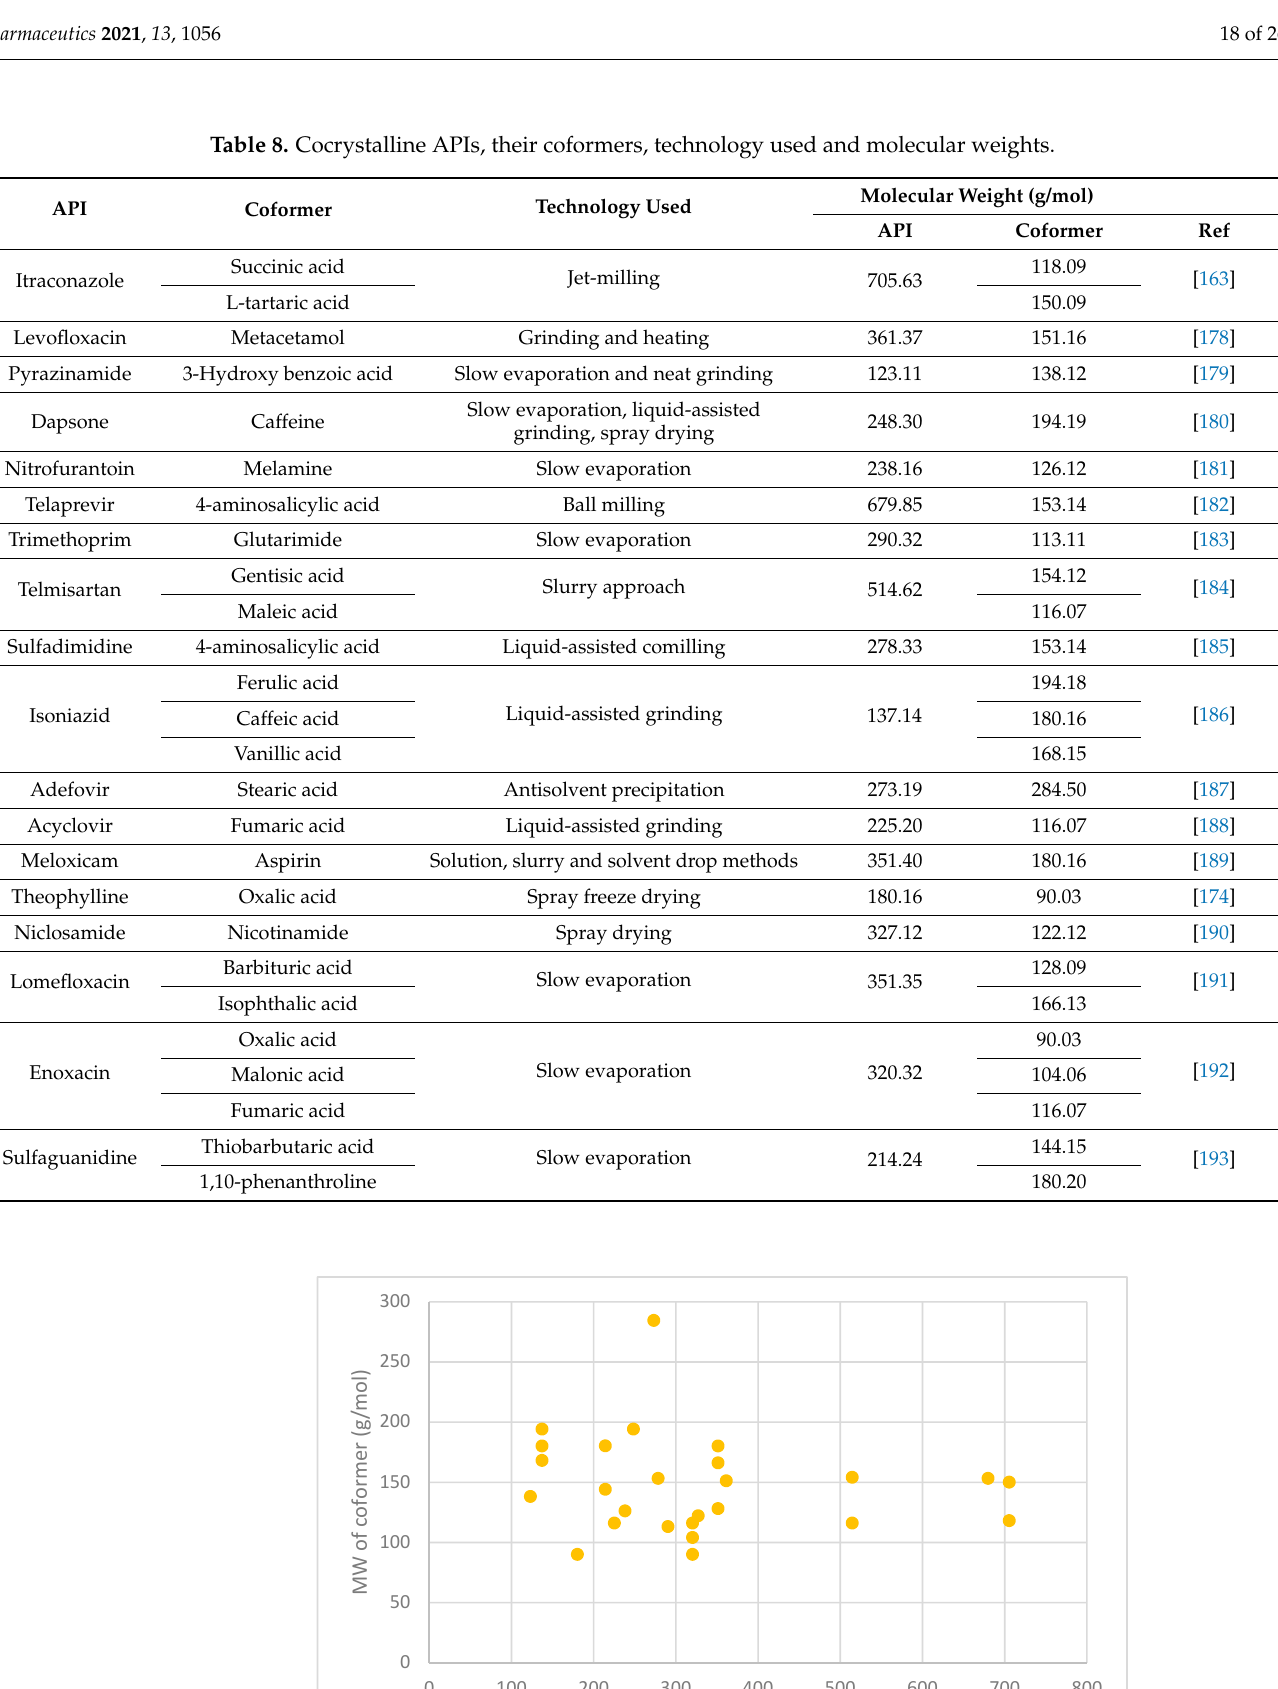
Table 8. Cocrystalline APIs, their coformers, technology used and molecular weights.